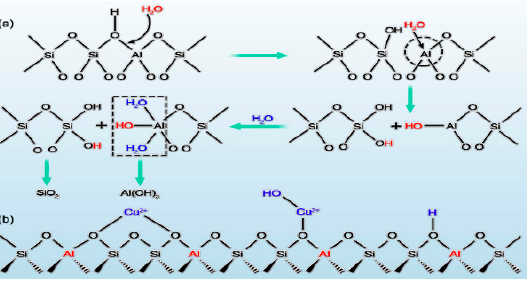
Figure 4. ( a ) Mechanism of dealumination over SSZ-13. Adapted with permission from Ref. [25]. Copyright 2015 ACS Catalysis. ( b ) Cu species reaction with water. Adapted with permission from Ref. [26]. Copyright 2017 ACS Catalysis.